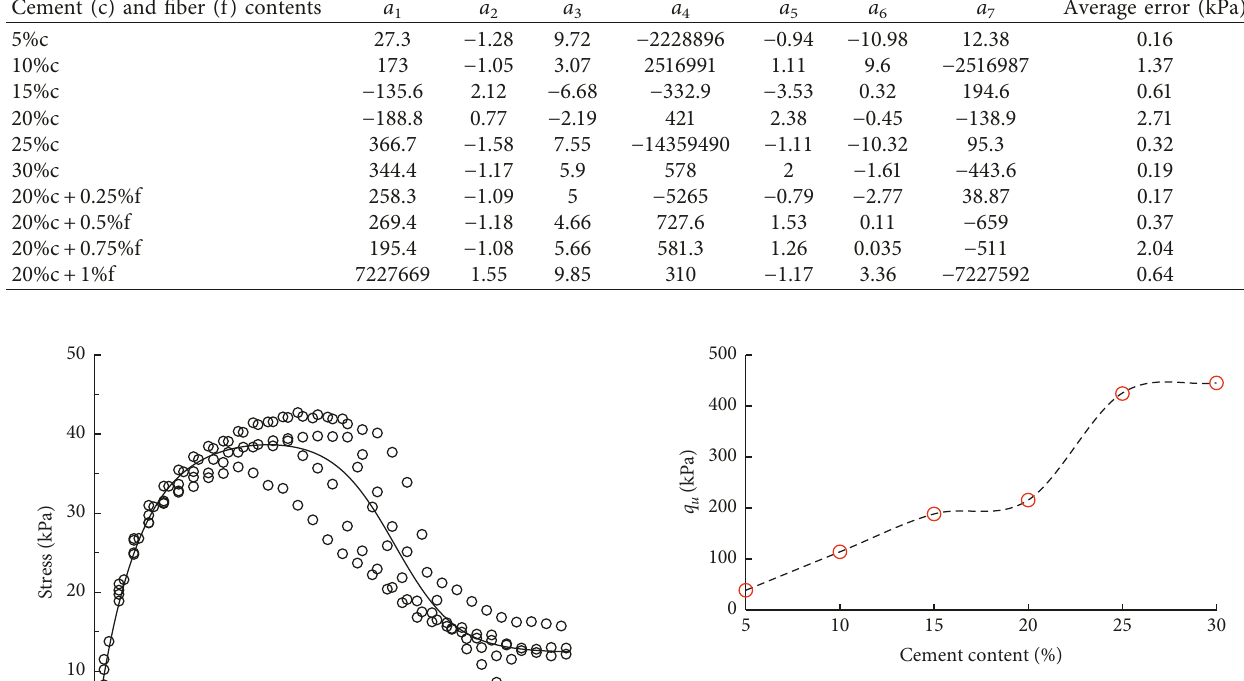
Figure 13: Peak strength q u of slurry with various cement contents.